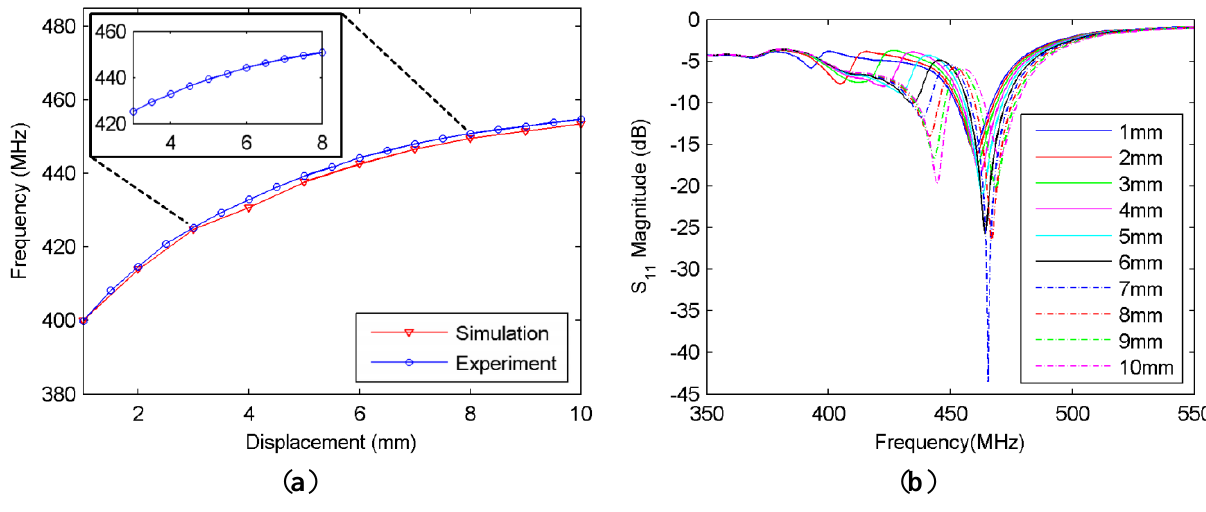
Figure 3. ( a ) The shift in the operating frequency measured as a function of the displacement d, presenting both simulation and experimental results; ( b ) Experimental S data that shows the shifting of the frequency peaks which are plotted in (a) for different displacement levels, d.